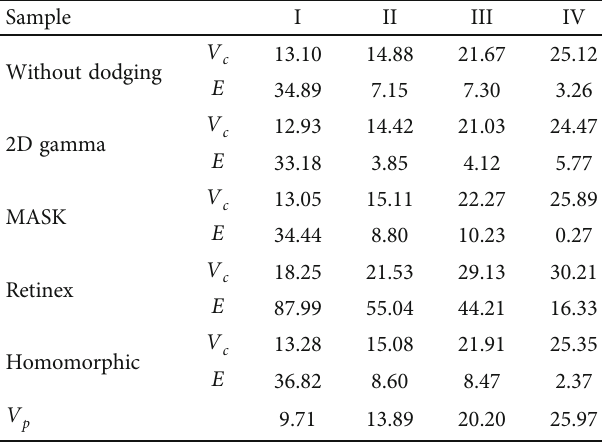
Figure 2: CT image segmentation: (a) without dodging; (b) MASK dodging; (c) Retinex dodging; (d) homomorphic fi lter dodging; (e) 2D gamma dodging; ( ∗ 1) void; ( ∗ 2) asphalt mortar; ( ∗ 3) aggregate. The range of “ ∗ ” is (a) – (e). Table 1: Proportion of pore structures that connected with the outside space